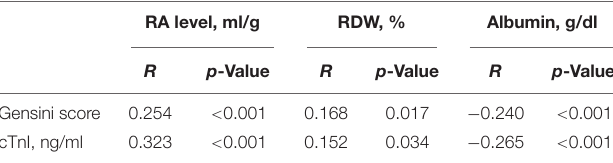
TABLE 4 | Pearson correlation analysis of the RA and clinical